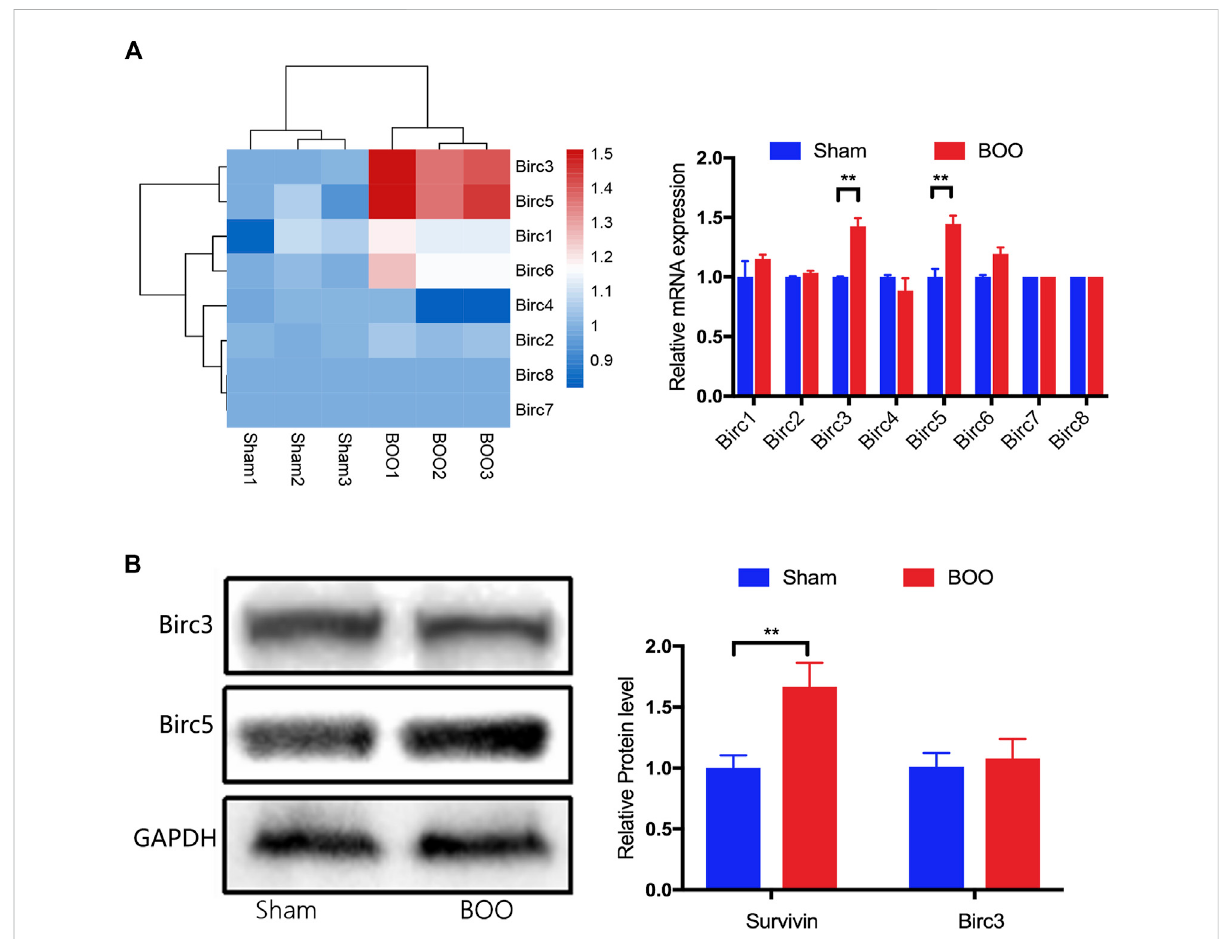
FIGURE 1 BOO-induced upregulation of survivin expression. (A) Microarray analysis of the IAP family members in the bladder between BOO group and sham-operated group. (B) The protein level of Survivin and BIRC3 in the bladder wall of sham-operated group and BOO group ( n = 8). Data are presented as the mean ± SD, ** p < 0.01; * p < 0.05; (Student ’ s t-